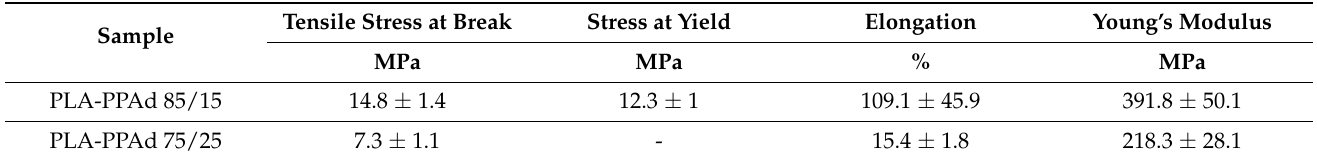
Table 4. Tensile test results. Student’s t-test between the two samples yielded p < 0.05 for tensile stress, elongation and Young’s modulus.